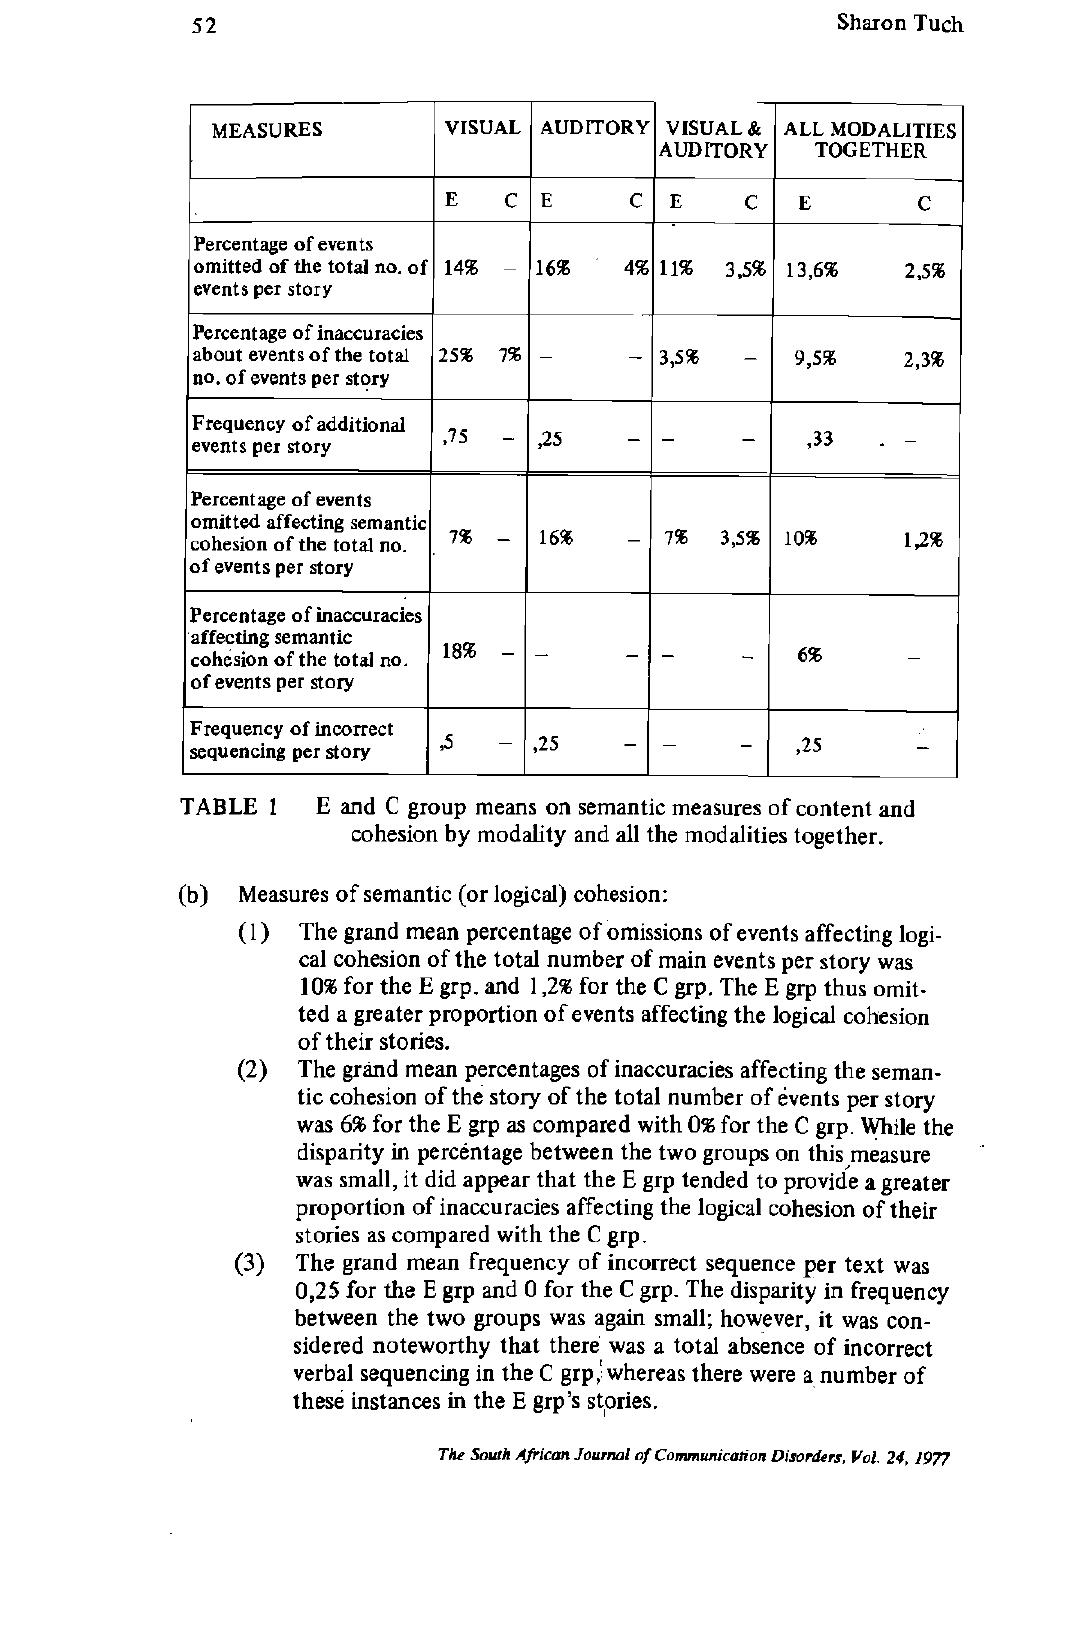
Ε and C group means on semantic measures of content and cohesion by modality and all the modalities